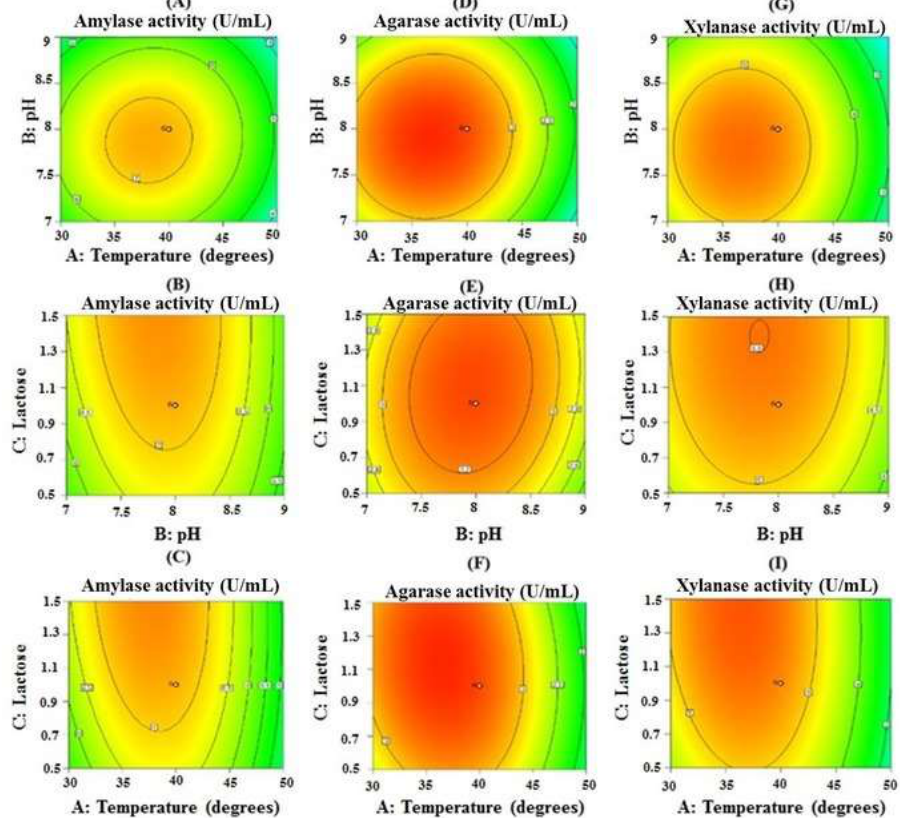
Figure 7. Contour plots of amylase activity ( A ) pH and temperature interaction with lactose constant ( B ) Lactose and pH with temperature constant ( C ) Lactose and temperature with pH constant. Contour plots of agarase activity ( D ) pH and temperature interaction with lactose constant ( E ) Lactose and pH with temperature constant ( F ) Lactose and temperature with pH constant. Contour plots of xylanase activity ( G ) pH and temperature interaction with lactose constant ( H ) Lactose and pH with temperature constant ( I ) Lactose and temperature with pH constant.